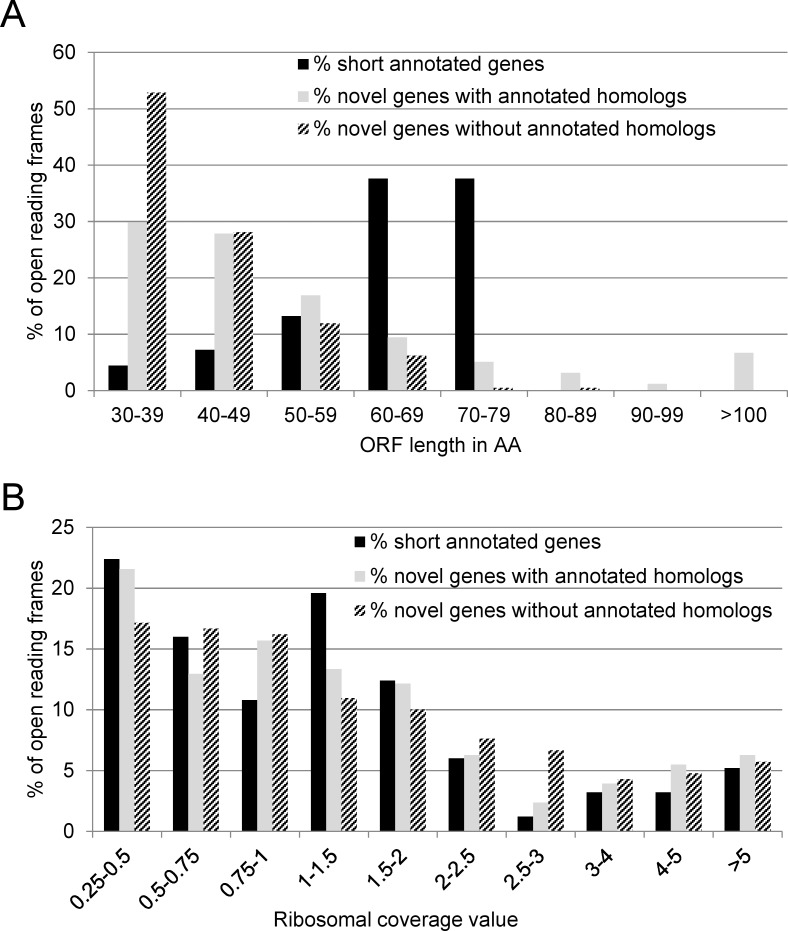
Length and RCV distribution of short annotated genes, novel genes with annotated homologs, and novel genes without annotated homologs.(A) The ORF length in AA was binned into eight categories and the number of ORFs for each gene group belonging to every category was determined. On average, the annotated genes are longer than the novel genes. The novel genes without annotated homologs have the shortest length. (B) The translatability expressed by the ribosomal coverage value (RCV) when growing in LB. The RCV was binned into ten groups. All three gene categories show a similar RCV distribution.